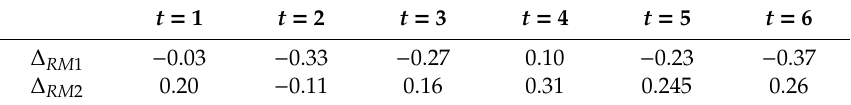
Table 13. Deviational parameters for the cost of AISI 304 steel.